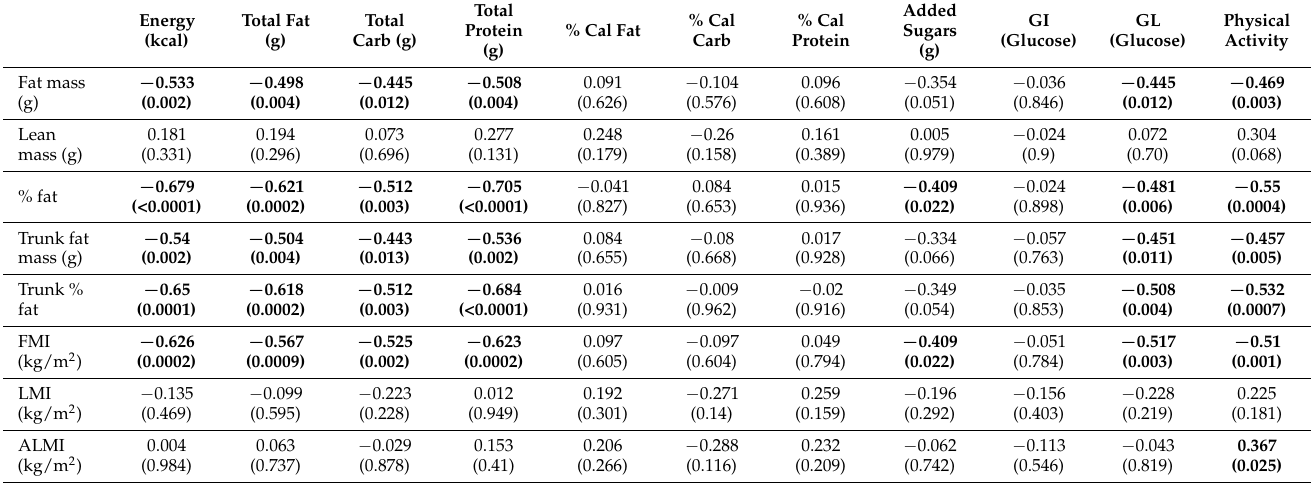
Table 4. Correlation analyses between dietary intake and body composition in participants with